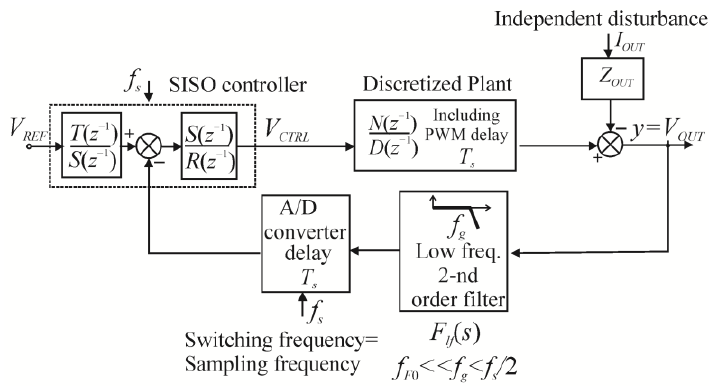
Figure 3. An advanced discretized SISO system.